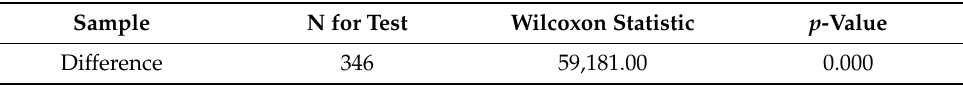
Table 2. Wilcoxon test for the ESV and